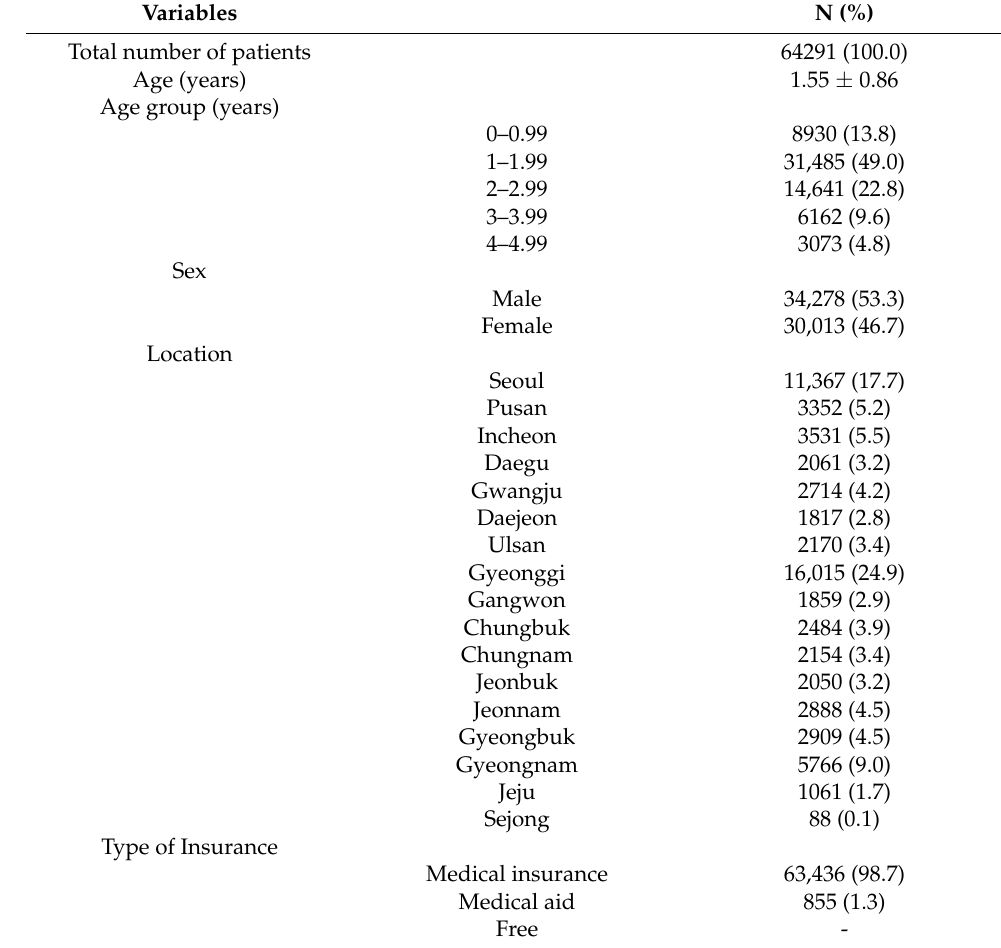
Table 2. Characteristics of patients.